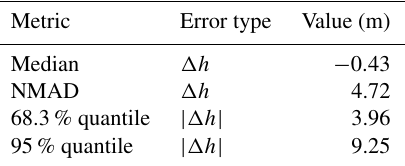
Table 2. Accuracy statistics for SPOT 6 satellite stereo DSM based on 15 ICPs. The error type (cid:49)h indicates the change in height be- tween the ICP and the DSM surface. Metric Error